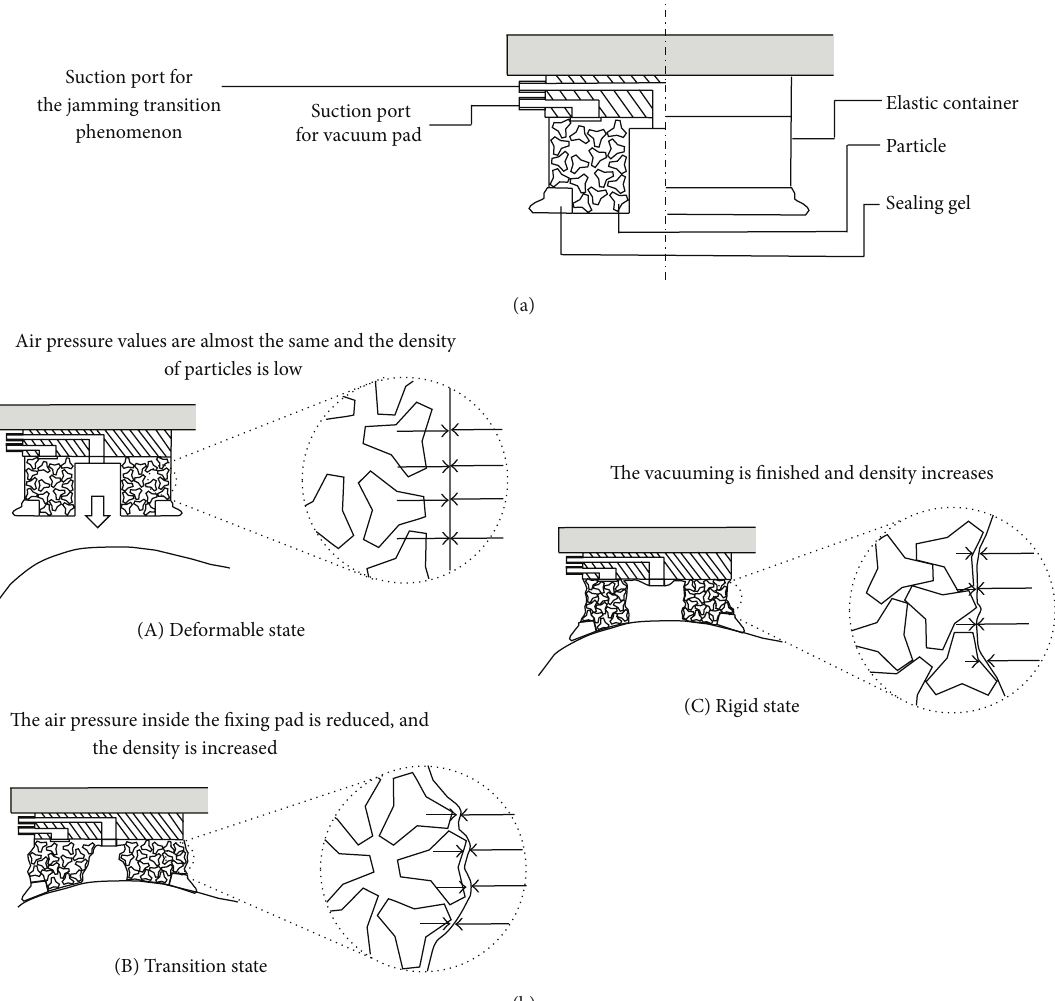
Figure 1: Process diagram of medical device affixation onto patient. (a) Half-section drawing of vacuum pad of fixing device. (b) Process diagram of fixation with proposed fixing device. (A) The fixing device freely deforms when the device is pressed against the object. (B) The fixing device contours to the patient’s body and transitions to a solid state by vacuuming air. (C) The vacuum pad of the solid fixing device sticks to the patient’s